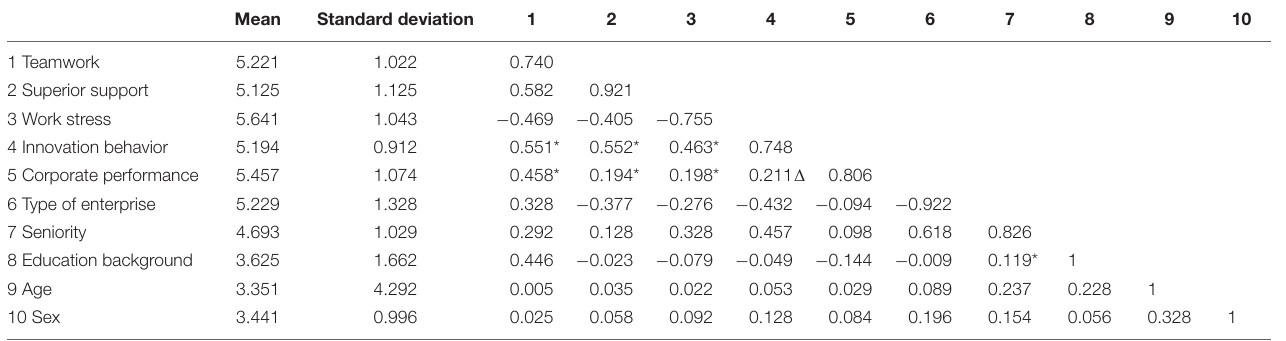
TABLE 6 | Statistical description and correlation coefficients between research variables.